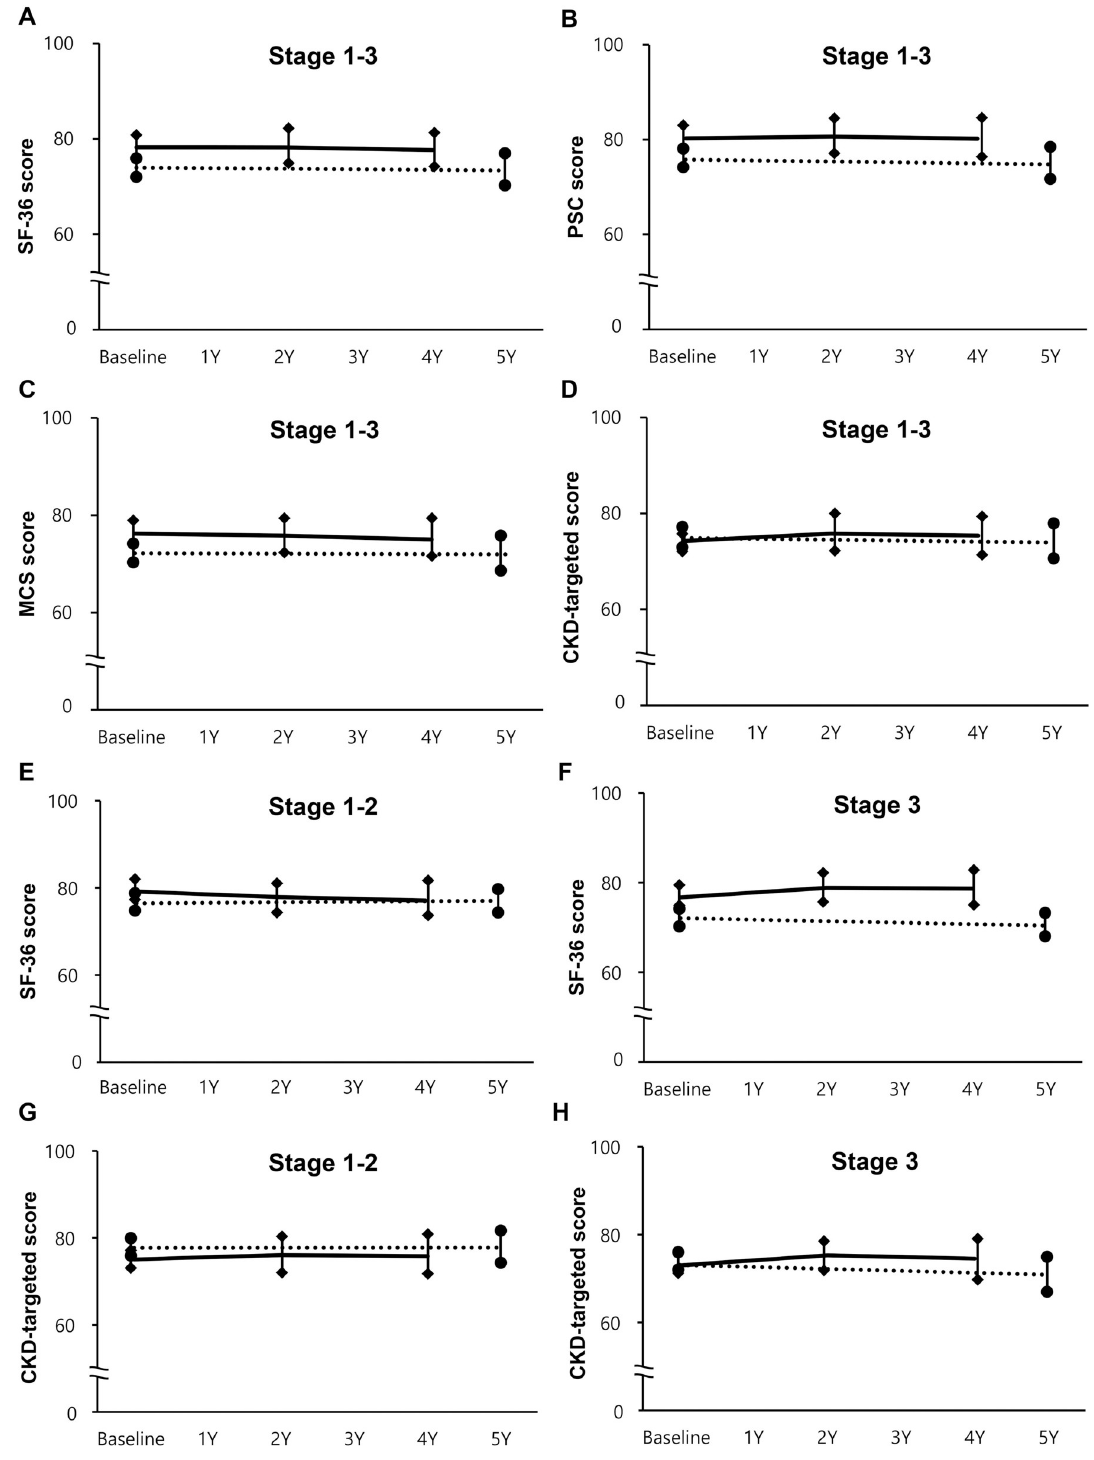
Fig 3. Comparison of changes in HRQOL between KT and CKD patients at the similar renal function according to CKD stage. (A) SF-36 score at CKD stage 1–3. (B) PCS score at CKD stage 1–3. (C) MCS score at CKD stage 1–3. (D) CKD-targeted score at CKD stage 1–3. (E) SF-36 score at CKD stage 1–2. (F) SF-36 score at CKD stage 3. (G) CKD-targeted score at CKD stage 1–2. (H) CKD- targeted score at CKD stage 3 were compared between KT (solid lines) and CKD patients (dot lines). Each value was displayed as the mean ± standard error of the mean. Chronic kidney disease; MCS, mental component summary score; KT, kidney transplantation; PCS, Physical component summary score. https://doi.org/10.1371/journal.pone.0257981.g003 PLOS ONE | https://doi.org/10.1371/journal.pone.0257981 October 4,